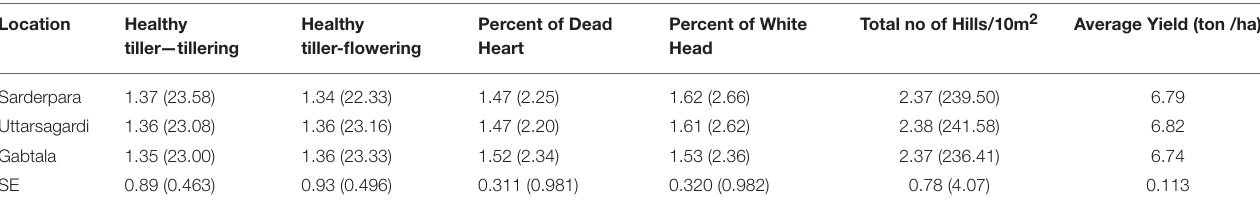
TABLE 5 | Effect of location on tillers, hills, dead heart, white head and yield of rice crops in 2012-13.